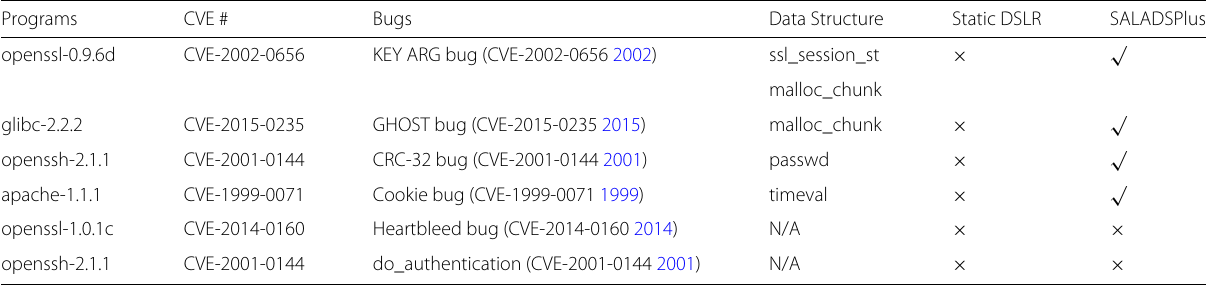
Table 1 Defense results of DSSR applications in two hours